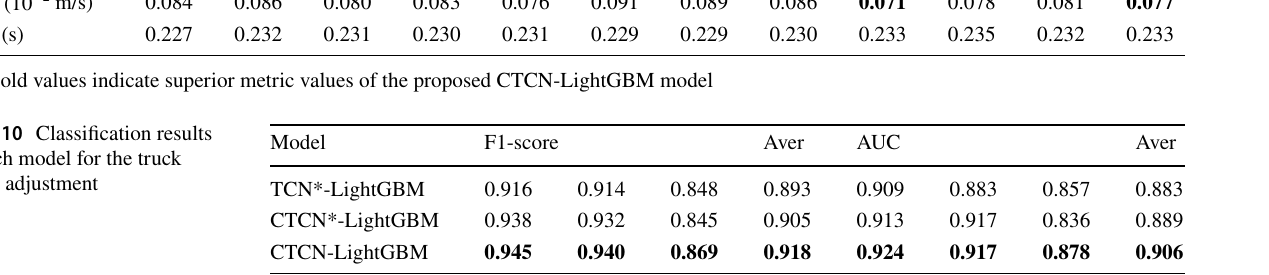
The bold values indicate superior metric values of the proposed CTCN-LightGBM Table 11 Prediction results of modelModel each model for the chute flow adjustment